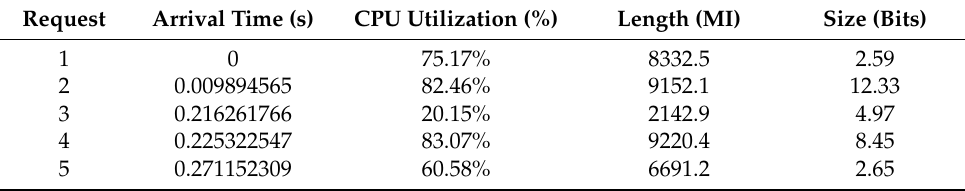
Figure 4. Gantt chart representing the offloading of requests using ESCOVE. Table 1. Specifications of requests used in the example.